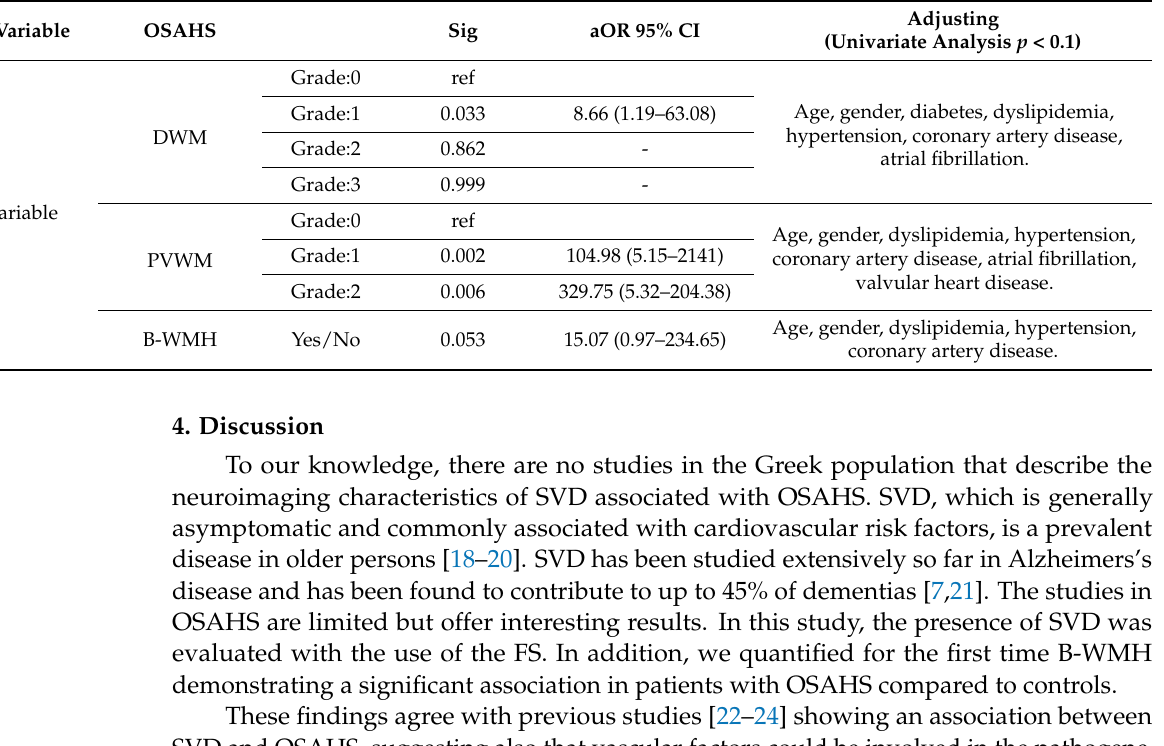
Adjusting (Univariate Analysis p <